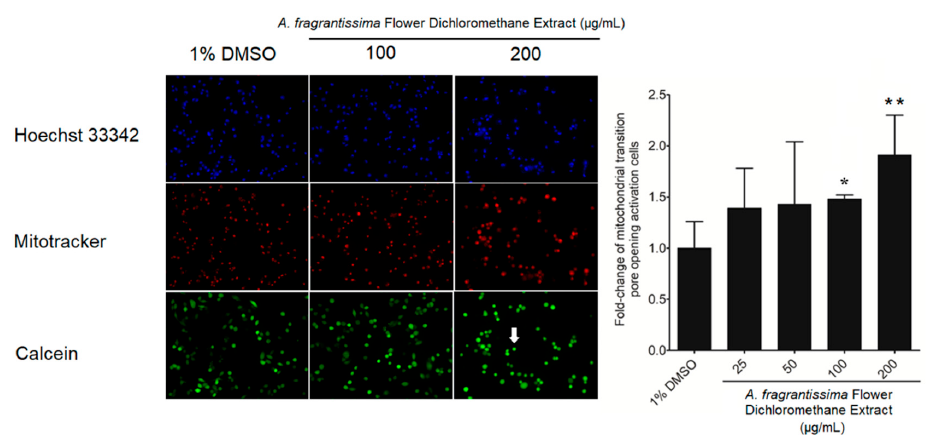
Figure 6. The increase in mitochondrial membrane potential opening activity in A. fragrantissima flower dichloromethane extract-treated TNBC MDA-MB-231 cells using confocal microscopy. The MDA-MB-231 cell treatment with A. fragrantissima flower dichloromethane extract (25–200 µ g/mL) showed an increase in the activity of the opening of the mitochondrial transmission membrane pores, as indicated by the arrow. * p < 0.05 and ** p < 0.01 vs. DMSO-treated